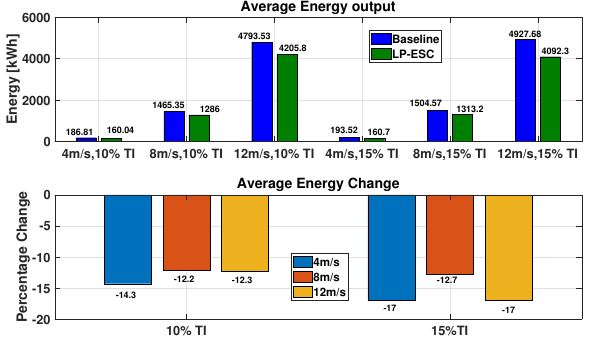
Figure 10. Energy capture comparison: Baseline vs. LP-ESC. Average energy output with baseline optimal torque gain and LP-ESC ( top ), percentage change in energy capture ( bottom ). The energy capture with LP-PIESC was also compared with the baseline controller. The average change in energy capture is shown in Figure